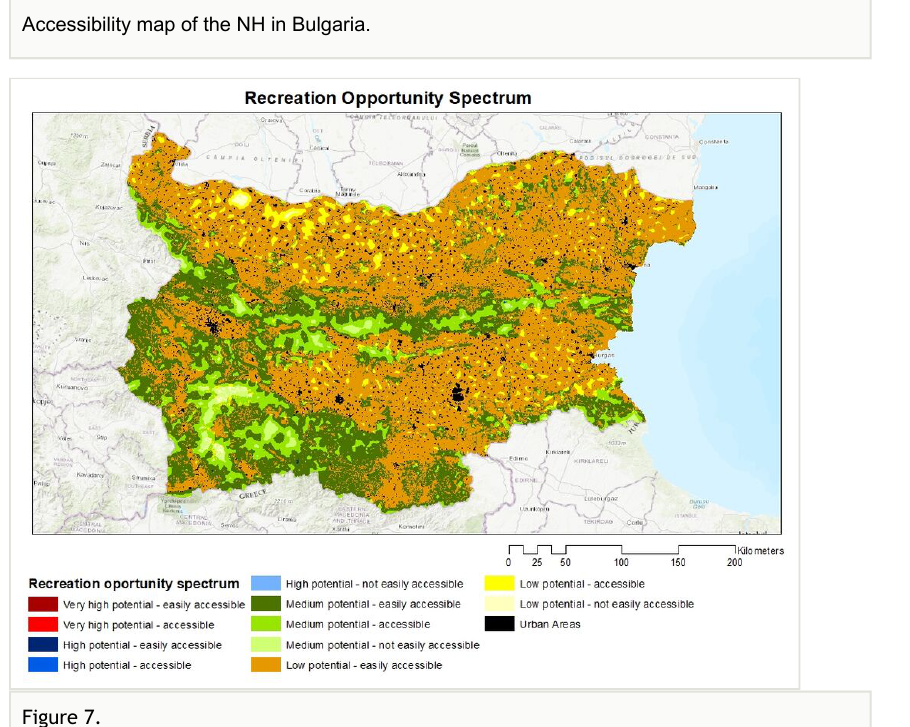
Figure 7. ROS of the NH in